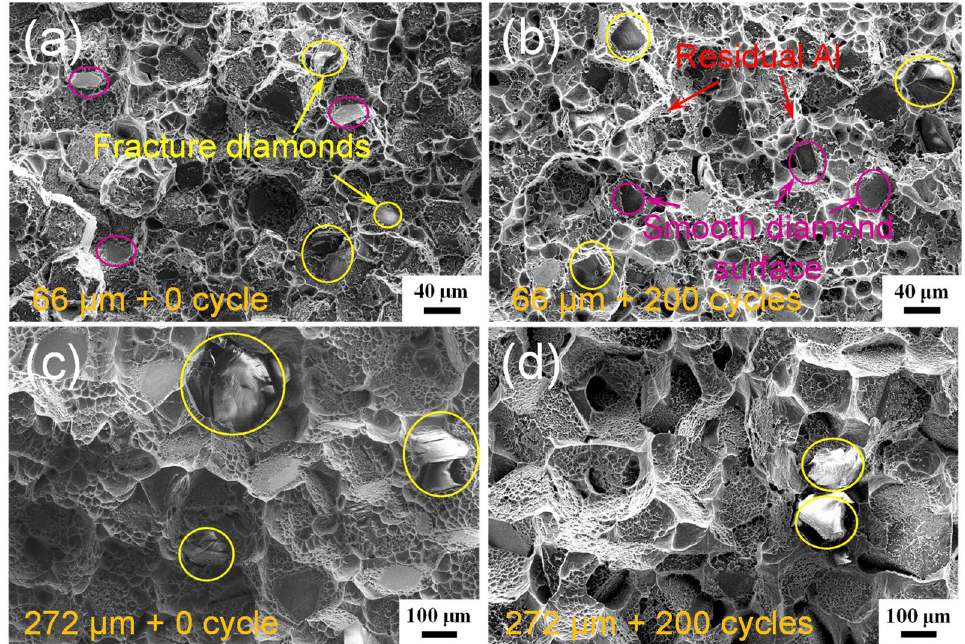
Figure 6. Fracture surfaces of the diamond/Al composites with different diamond particle sizes before thermal cycling: ( a ) 66 μm and ( c ) 272 μm, and after 200 thermal cycles: ( b ) 66 μm and ( d ) 272 μm.